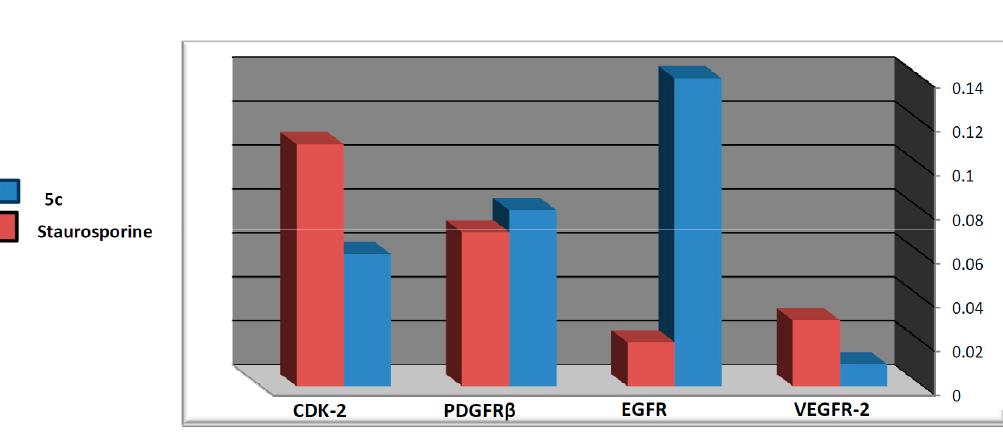
Figure 4. IC 50 of compound 5c against VEGFR-2, EGFR, PDGFR β and CDK-2 kinases in comparison with staurosporine.